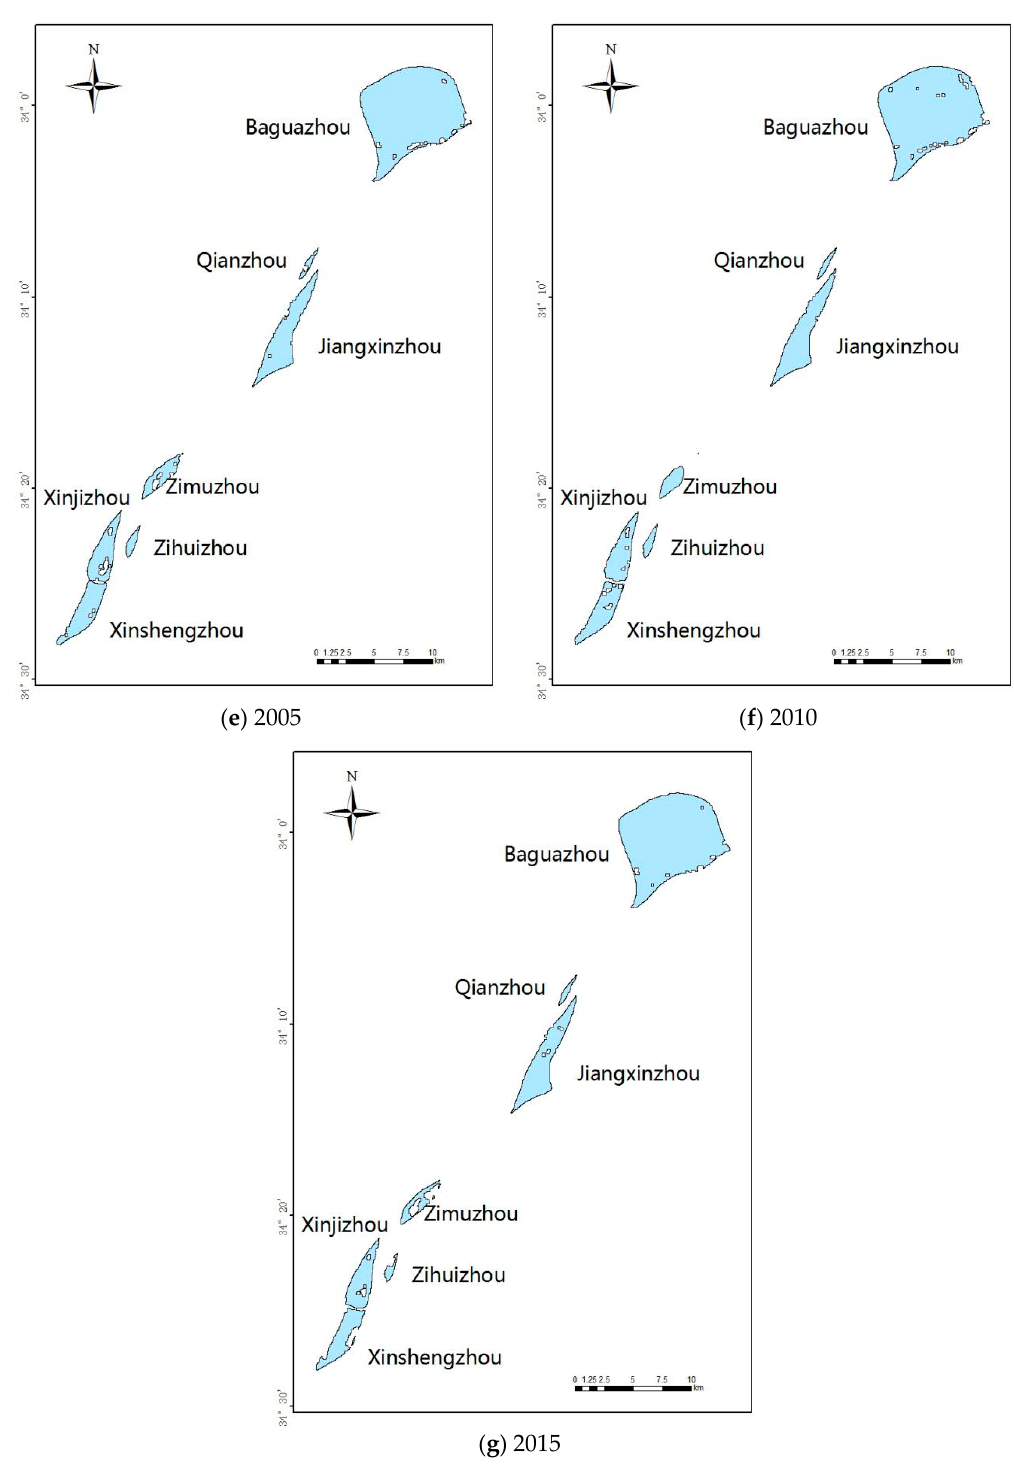
Figure 4. River island changes in NYR during 1985–2015 ( a – g ).